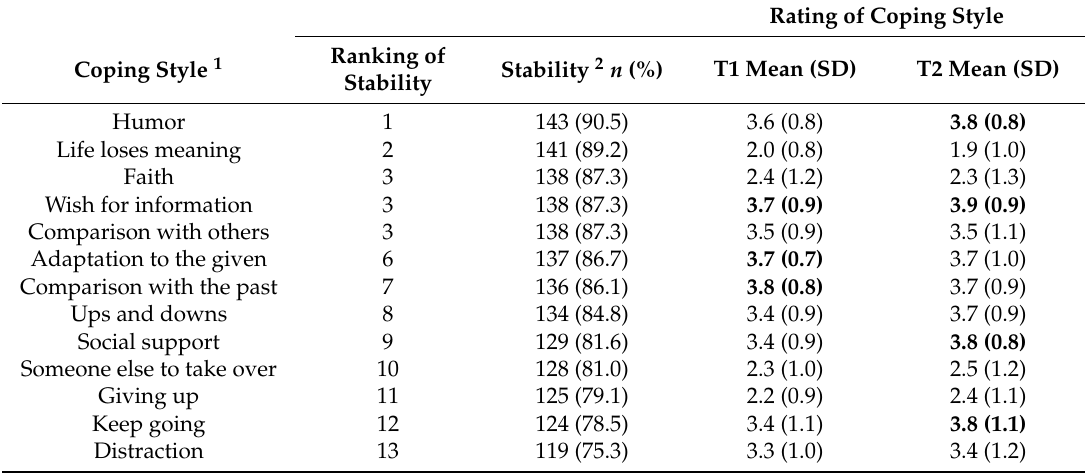
Table 3. Stability of coping styles over time: T1 to T2, sample size N =